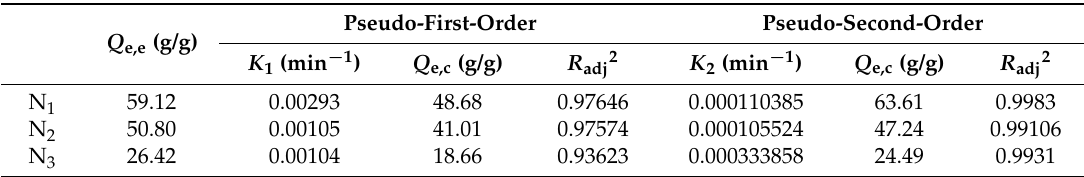
Figure 8. The swelling kinetics of γ -PGA/ ε -PL hydrogels in NaCl solution. 3.2.2.3. The Effect of CaCl 2 Concentration Similar to the adsorption kinetic in NaCl solution, as shown in Figure 9, the adsorption kinetics of γ -PGA/ ε -PL hydrogels in CaCl 2 solution were also fitted typical pseudo-second order kinetics model. Figure 10 described the plots for pseudo-first-order and pseudo-second-order kinetics of γ - PGA/ ε -PL hydrogels in N 1 , N 2 , and N 3 (N 1 : 0.0154 mol/L, N 2 : 0.0308 mol/L, and N 3 : 0.154 mol/L). Table 3 lists the kinetic parameters of the pseudo-first-order and pseudo-second-order models. Compared with the pseudo-first-order, it shows that the pseudo-second-order model presents a relatively higher correlation coefficient ( R adj2 > 0.99), and it has a closer experimental swelling degree ( Q e,e ) and calculated swelling degree ( Q e,c ). This indicates that the adsorption kinetic of γ -PGA/ ε -PL hydrogels in CaCl 2 solution follow the pseudo-second-order model and shows that the rate-limiting step of